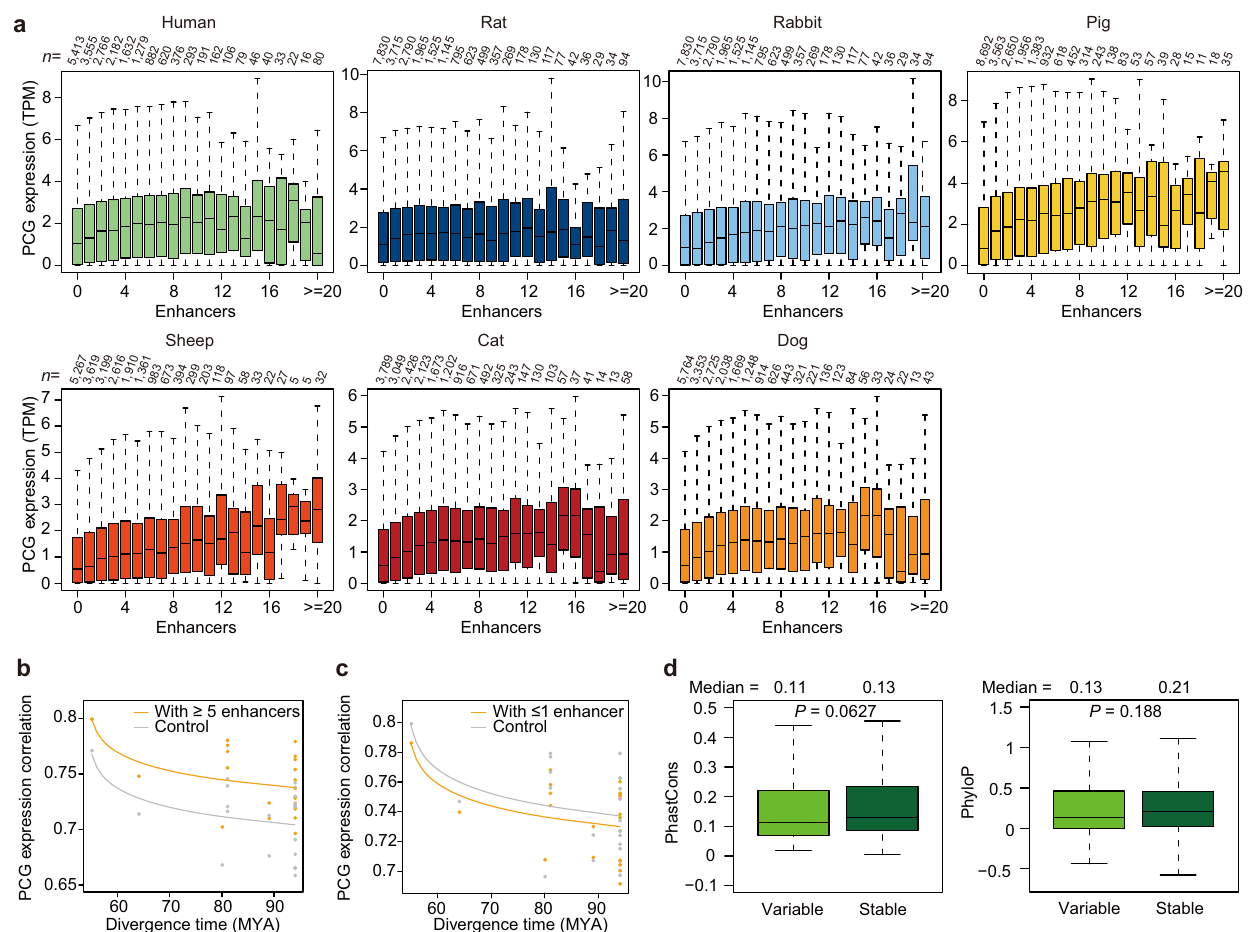
Fig. 7 The number of enhancers drives the stability of PCG transcription across the mammalian phylogeny. a Box plots showing distributions of PCG transcription associated with increasing numbers of enhancers in SAT in each mammalian species. Enhancers associated with a PCG have an additive effect on transcript levels. In the boxplot, the internal line indicates the median, the box limits indicate the upper and lower quartiles and the whiskers extend to 1.5 IQR from the quartiles. The numerical value above each bar indicates the number ( n ) of genes. b , c The number of associated/interacting enhancers contributes to the evolutionary stability ( b ) or viability ( c ) of PCG transcription. Pairwise Spearman ’ s correlation coef fi cients of transcription levels between species were plotted against the evolutionary distance of PCGs associated with multiple ( ≥ 5) enhancers (1557 PCGs) and compared with control PCG sets that have only one or fewer enhancers (enhancers ≤ 1) but a matched transcription level ( b ). For contrast, plots using the same analysis but showing PCGs associated with only one or fewer enhancers (1552 PCGs) compared with control PCG sets with multiple enhancers ( c ). The number of associated/interacting enhancers corresponds to the median number across species. The lines correspond to linear regression trends (after log transformation of the time axis). MYA: million years ago. d PCGs with either stable or variable transcription are largely similar in nucleotide sequence conservation (phastCons value [left panel] and phyloP value [right panel]). Stable PCGs: n = 245; variable PCGs: n = 245. (two-sided Wilcoxon rank sum test, Bonferroni-corrected P ). In the boxplot, the internal line indicates the median, the box limits indicate the upper and lower quartiles and the whiskers extend to 1.5 IQR from the quartiles. Source data are provided as a Source Data fi le. pig reference genome using a stringent fi ltering pipeline and classi fi ed them into (catalogue no. GNO15), were obtained from the China Infrastructure of Cell Line long noncoding RNAs (lncRNAs) and transcripts of unknown coding potential Resources and Stem Cell Bank of the Chinese Academy of Sciences, respectively. (TUCPs). For circRNA prediction, we retrieved RNA-seq reads that were mapped We constructed rRNA-depleted and random priming RNA-seq libraries and to back-splicing junction sites using CIRCExplorer2 (version 2.3.2) 96 , with putative sequenced them on the Illumina HiSeq X Ten platform to produce an average of ~49 million 150-bp paired-end raw reads and ~48 million high-quality reads for circRNAs required to have more than two independent junction-spanning reads. each library. Sequenced reads were aligned to the pig reference genome (Sscrofa Correspondingly, we also performed small RNA sequencing. We used pig miRNAs 11.1, GCA_000003025.6) by the STAR alignment tool (version 2.5.3a) 93 , with on annotated in the miRbase 19 database, as well as putative miRNAs annotated using average ~96% (~85.76 million) of aligned reads for each individual library. other mammalian and avian miRNA sequences as references that were not present For unbiased representative construction of the pig transcriptome, 33 tissues/cell in the current pig genome. lines (87 samples) comprising the core atlas dataset were chosen for de novo Gene-level transcript abundance was estimated as transcripts per million (TPM) transcriptome assembly. The aligned reads of these samples were assembled with using the high-speed transcript quanti fi cation tool Kallisto (version 0.43.0) 97 . For Cuf fl inks (version 2.1.1) 94 . We employed a previously reported computational method PCGs, TUCPs, and lncRNAs, we considered a gene as detected/transcribed if it had an expression value greater than 0.1 TPM in at least one sample. For miRNAs and to fi lter out library-speci fi c background noise and predict the most likely isoforms from circRNAs, we used a cut-off of 1 TPM and 0.05 TPM in at least one sample, the assemblies of transcript fragments (transfrags). We obtained high-quality assemblies respectively. containing reliable transcripts which were further submitted to construct transcriptome maps by TACO 95 (a meta-assembly method with a robust solution for leveraging the vast RNA-seq data landscape for transcript structure prediction). To facilitate further analysis of the pig transcriptome, we estimated the coding Reconstruction of 3D genome structures . To visualize the location dependence of potential of putative non-coding transcripts that were not annotated as PCGs in the transcription within the nuclear space, we performed an in situ Hi-C experiment for a NATURE COMMUNICATIONS| (2021) 12:3715